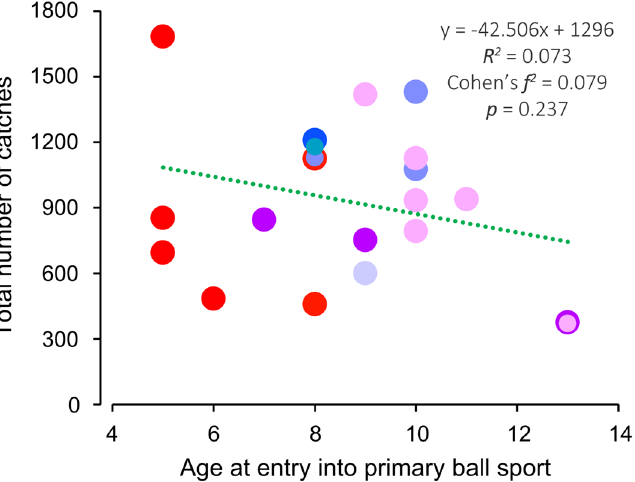
Figure 3. Relationship between the age at entry into the primary ball sport and the total number of catches. The color of each plot corresponds to the identically colored sports in Fig. 1. The overlaid plots can be displayed by